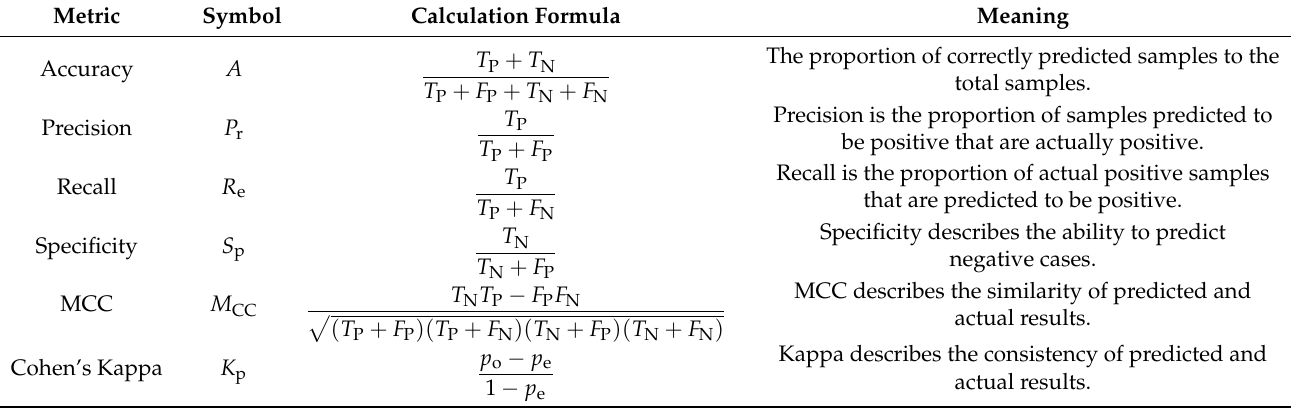
Table 1. The metrics used in this